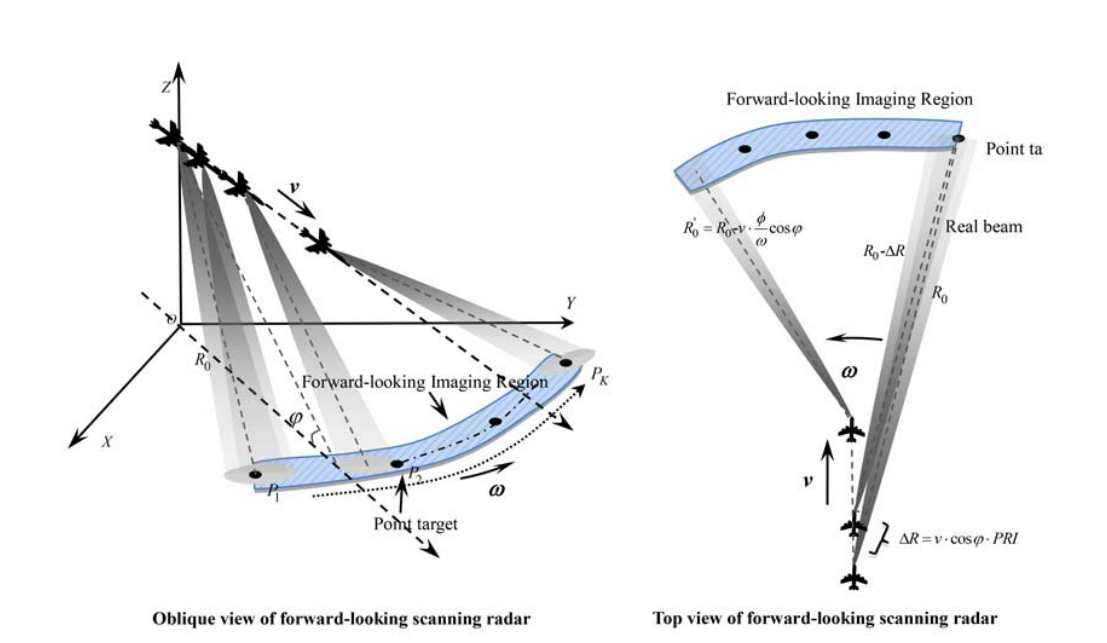
Figure 1. Geometric model of forward-looking scanning